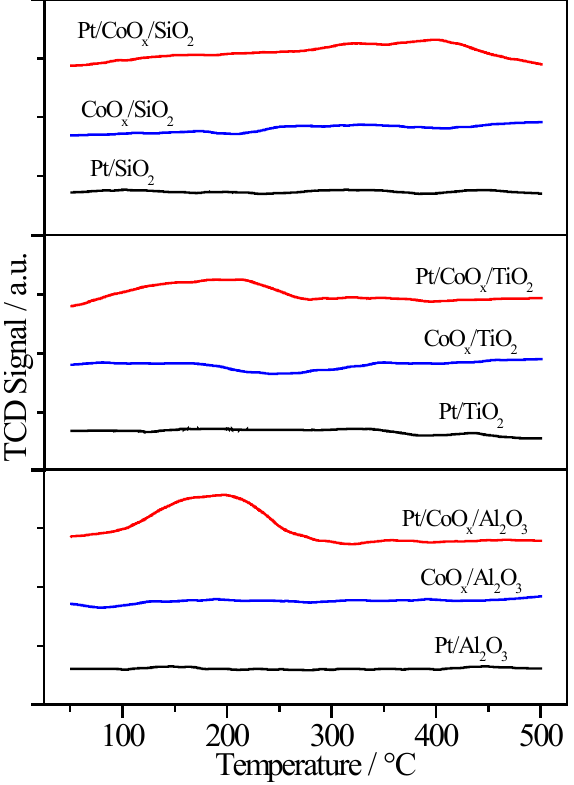
Figure 19. O 2 -TPD profiles of SiO 2 , TiO 2 , and Al 2 O 3 -based